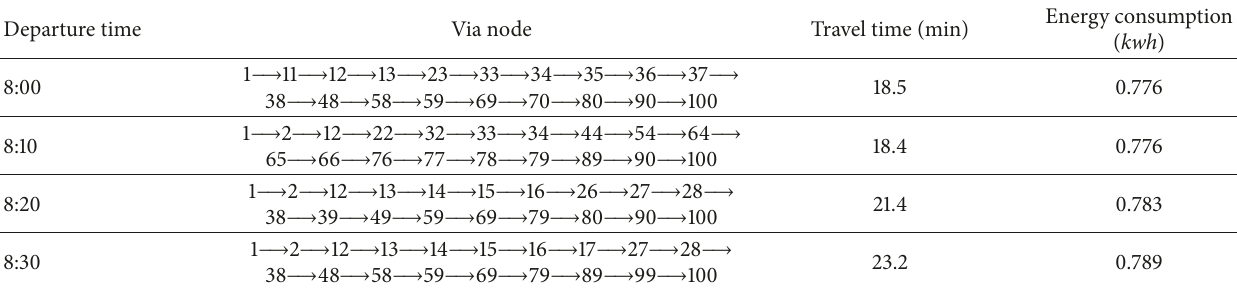
Figure 10: The simulation of real-time traffic network with spilt signal phase nodes. Table 6: The shortest routes from node 1 to node 100 at different departure time (in Scenario